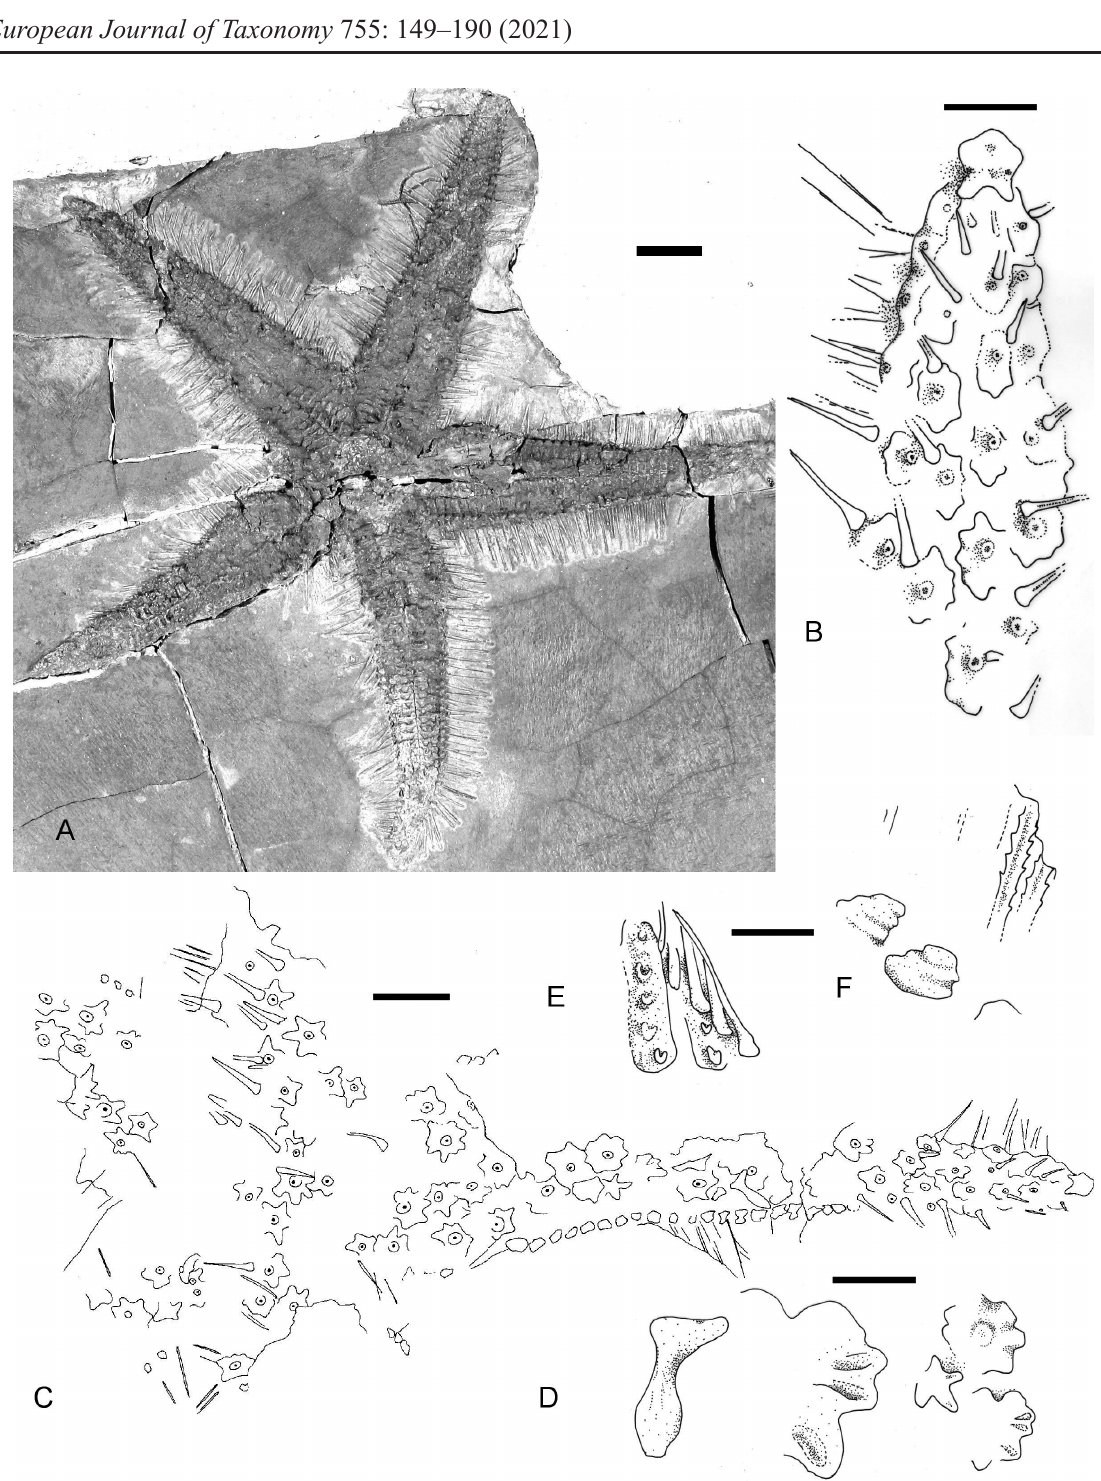
Fig. 14. Plesiastropecten hallovensis Peyer, 1944. A . Holotype (MZA L13a), the original of Peyer (1944: pl. 7) and Blake (1984: fig. 1a–h). B . Enlargement of distal arm. C–F . Line drawings of MZA L 13b/32a–e. C . Ossicle distribution of entire individual; note large, stellate abactinal ossicles which each carry a large boss for attachment of a single spine. D . Ambulacral ossicle, in abactinal view, and two abactinal ossicles. E . Adambulacral ossicle with spines attached. F . Two marginal ossicles, with serrated spines attached. Provenance: Lower Jurassic (Hettangian, liasicus ammonite Zone) of Hallau, Canton Schaffhausen, Switzerland. Scale bars: A = 10 mm; B–C = 5 mm; D–G = 2